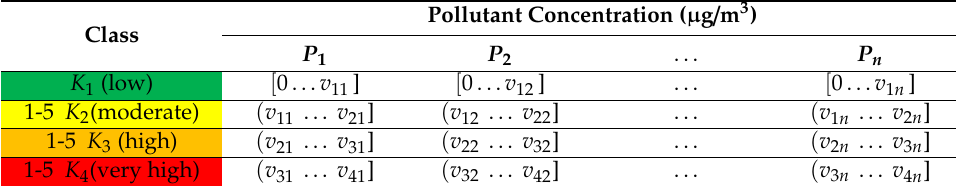
Table 2. Model table of concentration limits for each class .